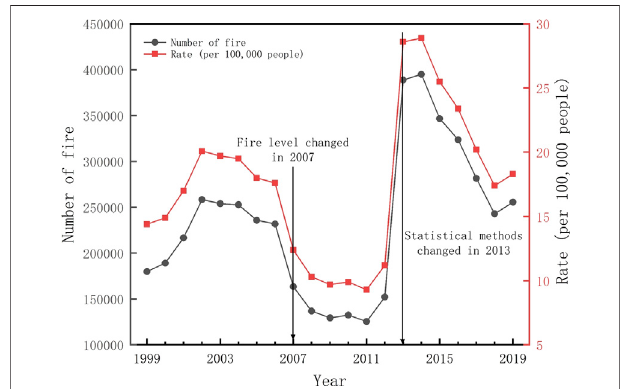
FIGURE 2 | The number and frequency of fi res.